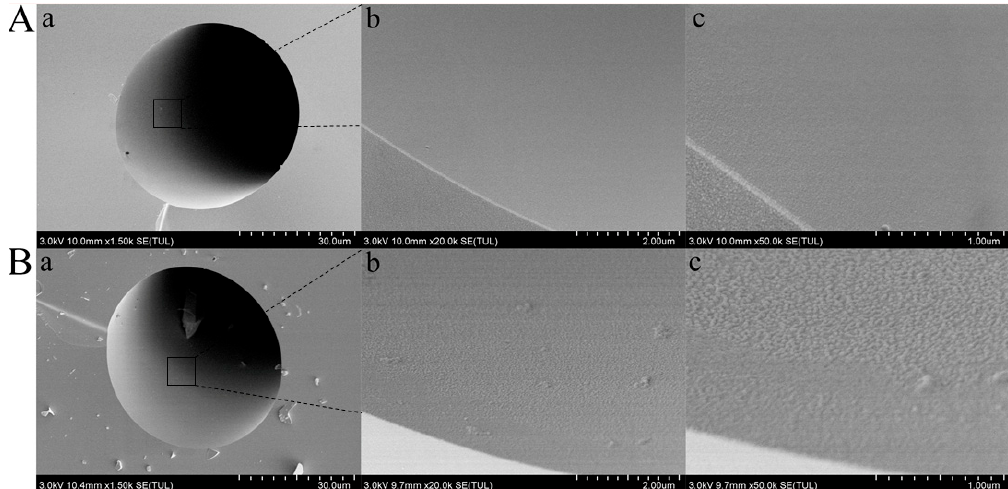
Figure 2. FESEM images of the inner wall of bare capillary ( A ) and PDA/L-Arg@capillary ( B ) with different magnification (a. 1.50 k, b. 20.0 k, c. 50.0 k).